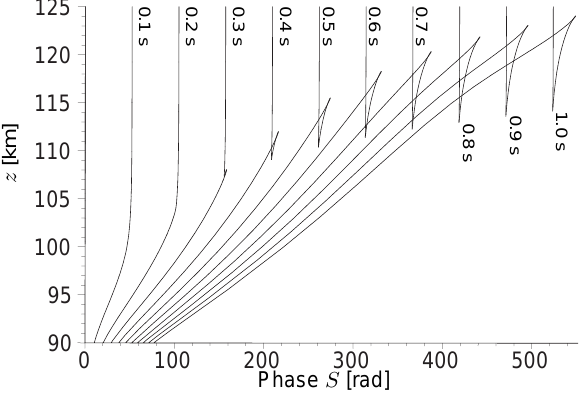
Fig. 3. Characteristic paths z i (t) obtained by solving the coupled system given by Eqs. (26) and (27) for a 50 mV/m electric field under the assumption of an initially perfectly field-aligned structure.